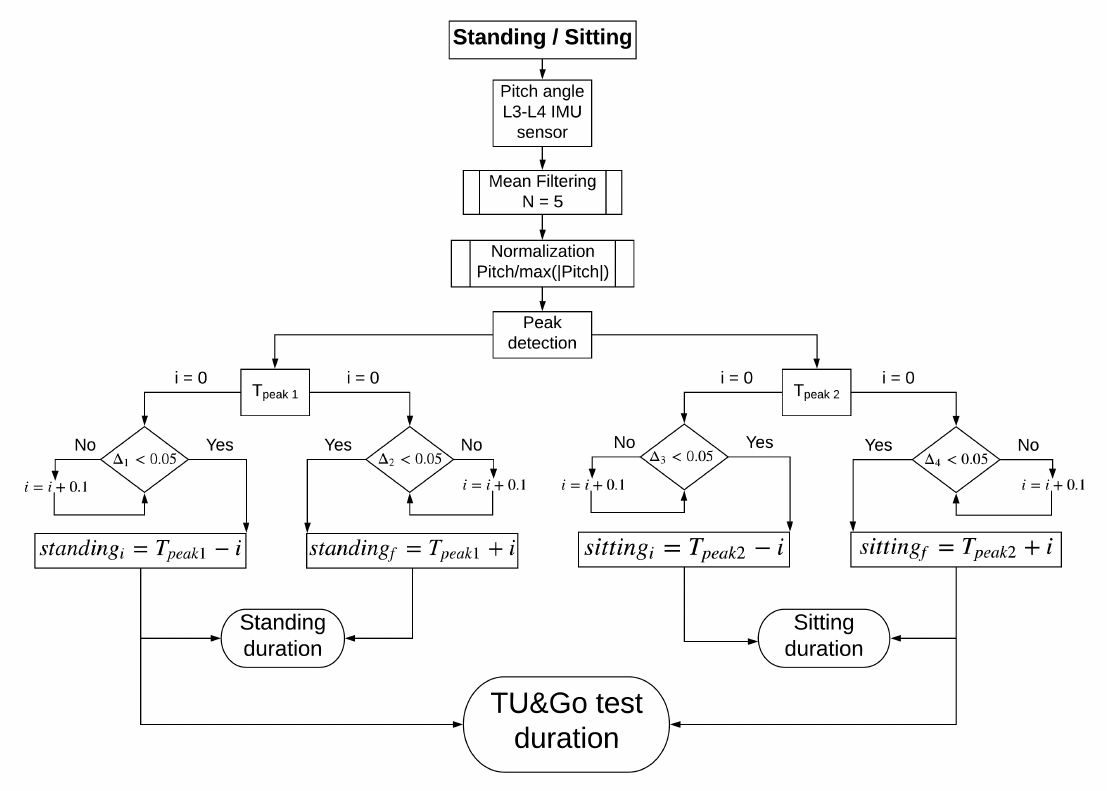
Figure 7. Automatic feature-based segmentation algorithm for the standing and sitting activities in the 3–m TU & Go